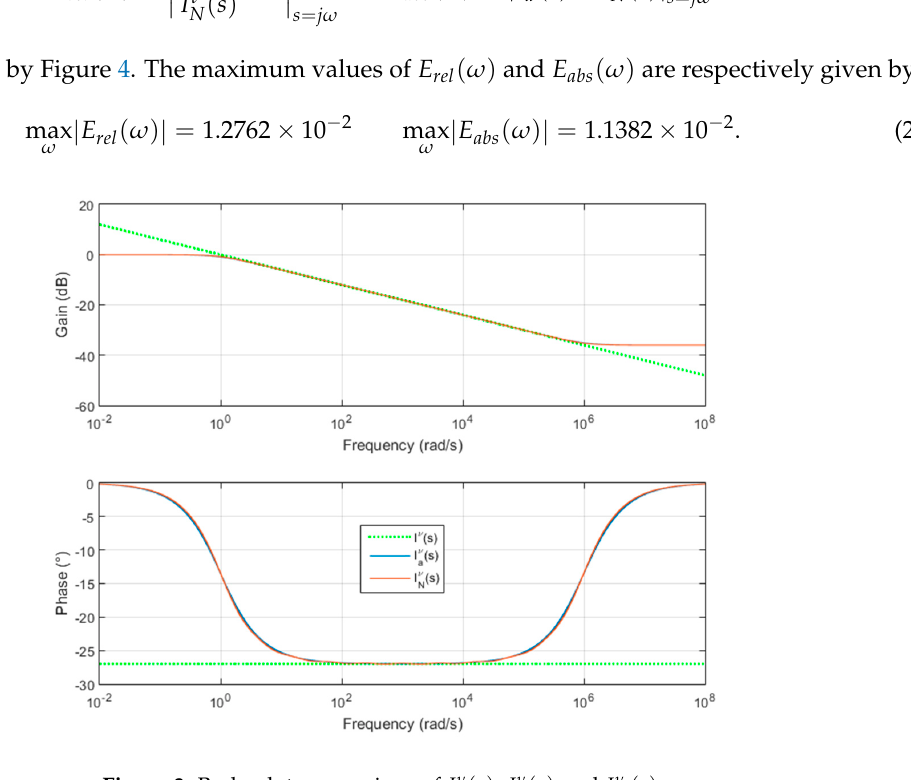
Figure 3. Bode plot comparison of I ν ( s ) , I ν a ( s ) and I ν